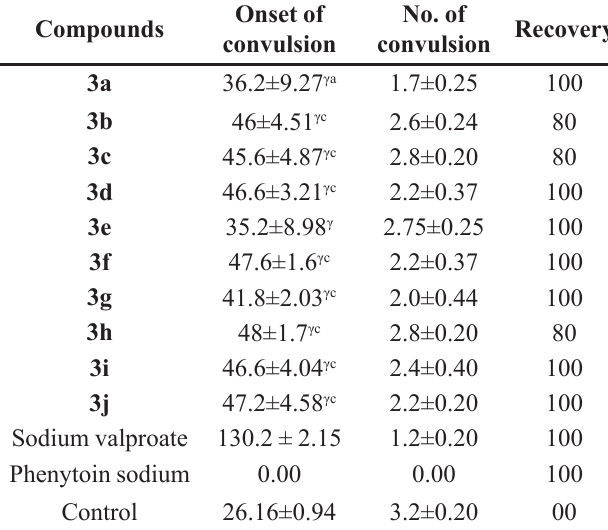
TABLE III - Anticonvulsant activities of